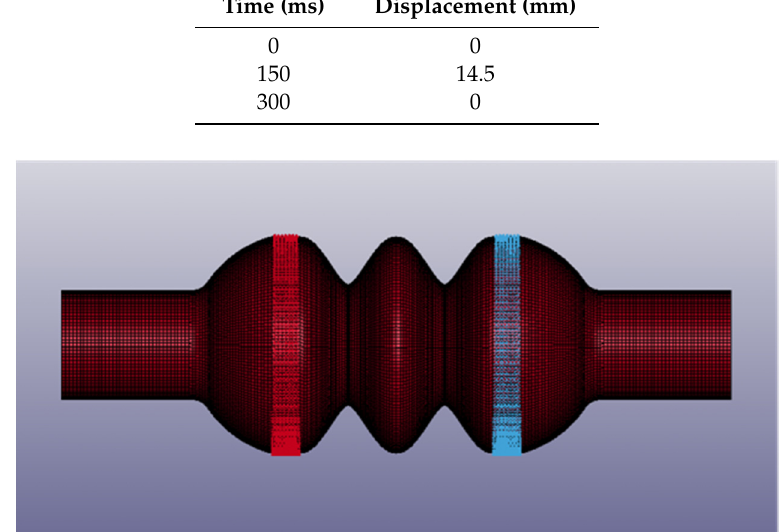
Figure 5. Details of the third chamber configuration (Model C): moving nodes are in red and in blue. The image was captured from LS Pre-Post ® .